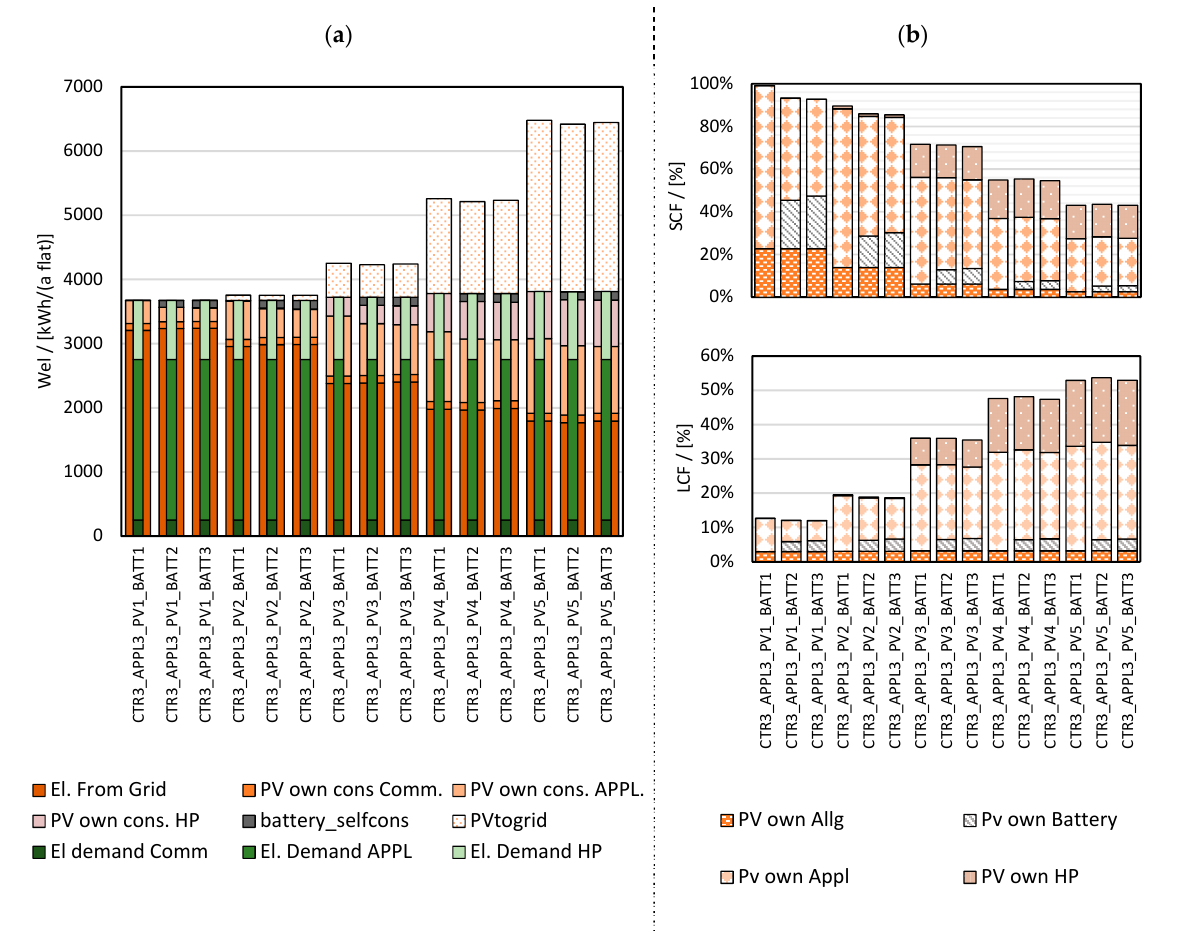
Figure 14. ( a ) Electricity balance for the cases implementing the CTR3 and APPL3 varying the PV and battery sizes; ( b ) Supply Cover Factor (SCF) and Load Cover Factor (LCF) of the same cases.